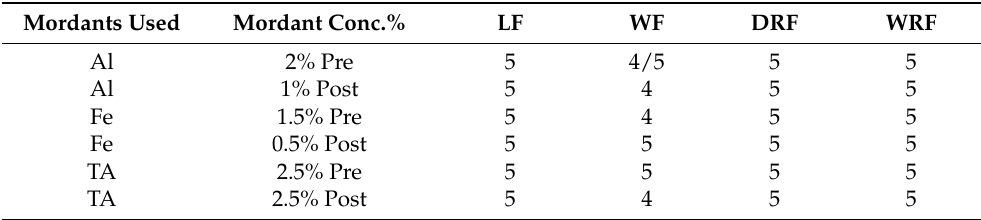
Table 6. Fastness grading of silk fabric dyed with acidic extract of red sandalwood before and after chemical mordanting at selected conditions. Mordants Used Mordant Conc.% LF WF DRF WRF Amaltas 1% Pre Amaltas